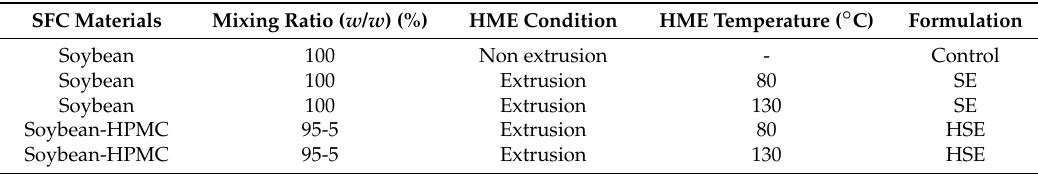
The soybean-polymer compositions and hot melt extrusion (HME) conditions of developed